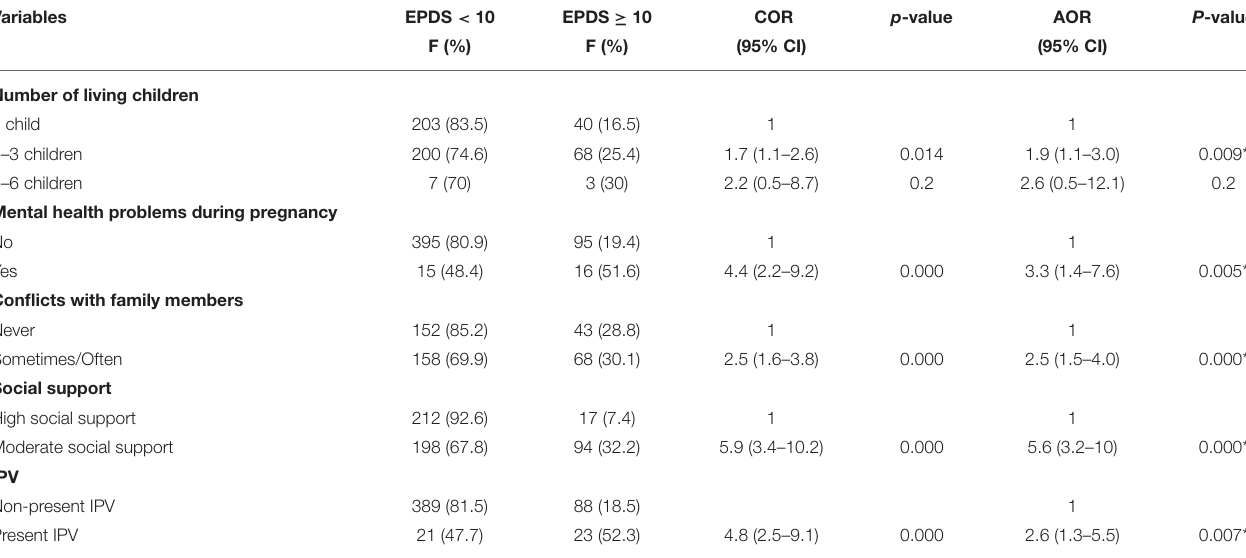
TABLE 4 | Risk factors associated with PDS among